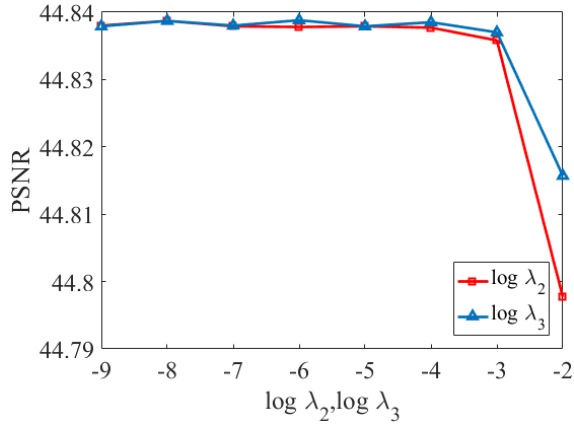
Figure 4. PSNR values for different log λ 2 and log λ 3 .